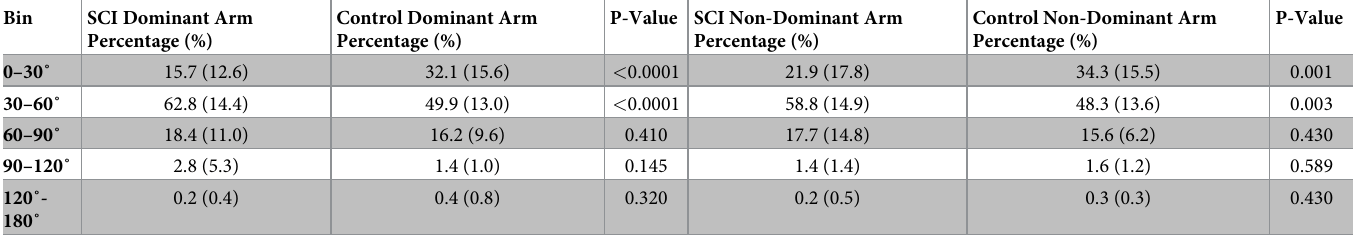
Table 2. The average (SD) percentage of the day individuals with SCI and matched able-bodied controls spent in five humeral elevation bins throughout one or two days. Bin SCI Dominant Arm Percentage